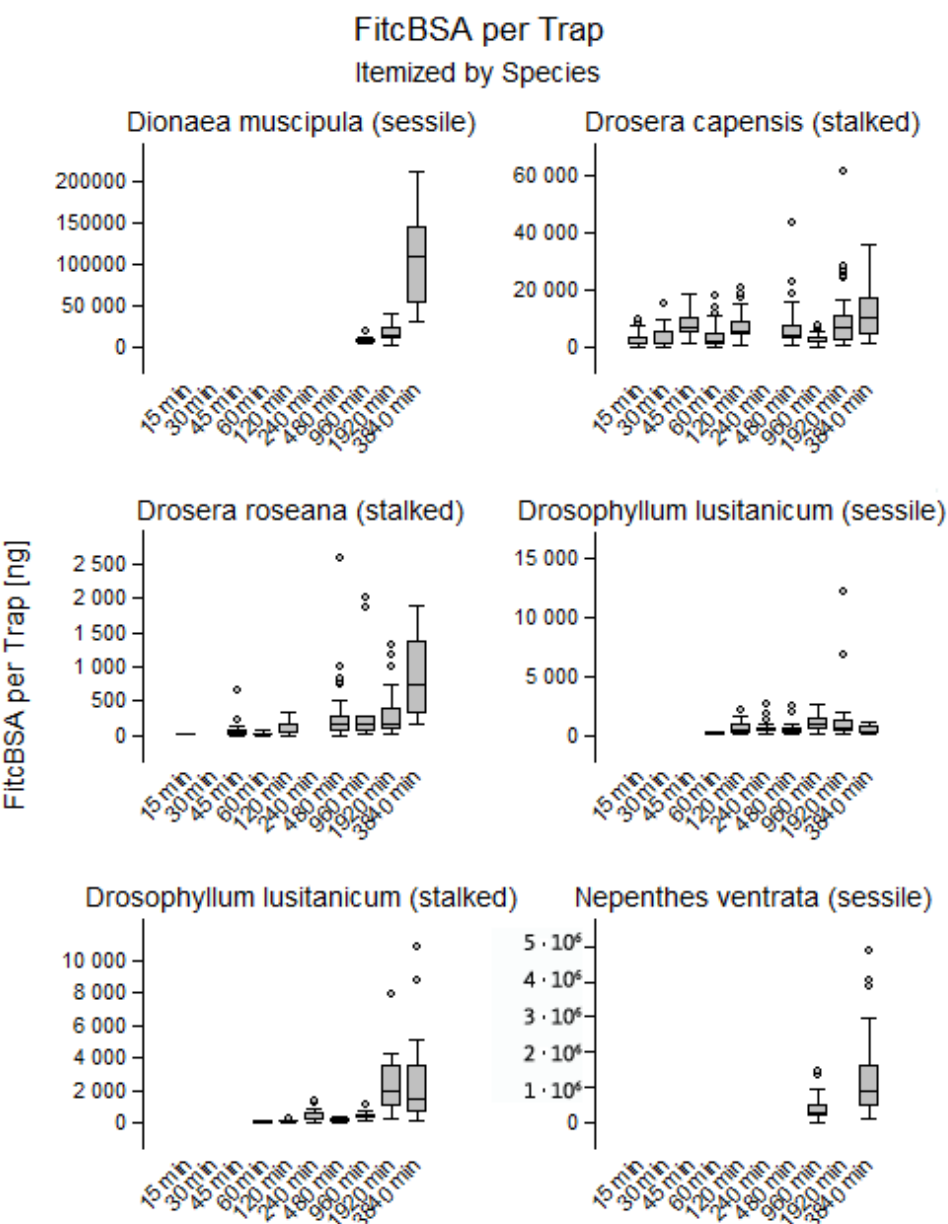
Figure 4. Temporal changes of total FITC-BSA content per trap (DZ) in Dionaea muscipula , Drosera roseana , Drosera capensis , Nepenthes × ventrata and stalked and sessile glands in Drosophyllum lusitanicum . Throughout the observed timeframe, the amounts of FITC-BSA increased in all species, except in sessile glands of D. lusitanicum ; here the content remained constant at a level. The overall uptake of nutrients was assessed by the N (155.8 mg/g) and S (17.8 mg/g) content of FITC-BSA. Uptake rates were estimated by the slope of the linear regression models in order to compensate for different latency times. In the sessile glands of D. lusitanicum , 12 ng/d N and 1 ng/d S was absorbed, but these uptake rates did not significantly differ from zero. In all tentacles of adhesive traps, significant rates of uptake were found, whereby uptake rates were roughly correlated with trap size: 36 ng/d N and 4 ng/d S in D. roseana , 135 ng/d N and 15 ng/d S in D. lusitanicum , and 475 ng/d N and 54 ng/d S in D. capensis . In both species with temporary stomachs, absorption rates were far higher: 8.3 µ g/d N and 0.9 µ g/d S in D. muscipula and 63.6 µ g/d N and 7.3 µ g/d S in N. × ventrata . The results of all regression analyses are in the Supplementary Material (Table